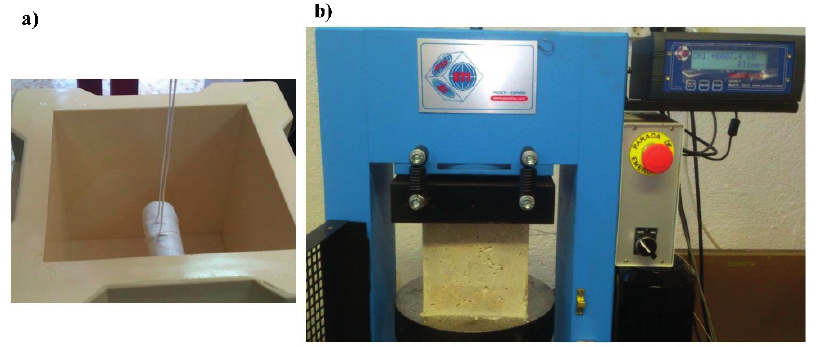
Figure 7. ( a ) MMCC sensor located in the centre of a normalized cubic mold; ( b ) Experimental set-up for the compressive loading